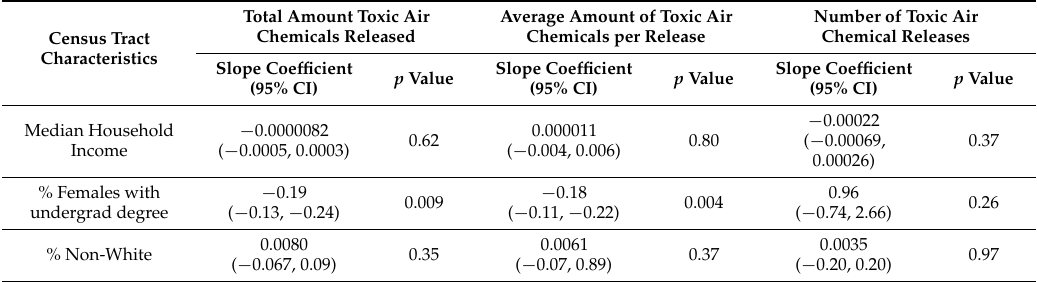
Table 5. Multivariate model results explaining TRI chemical